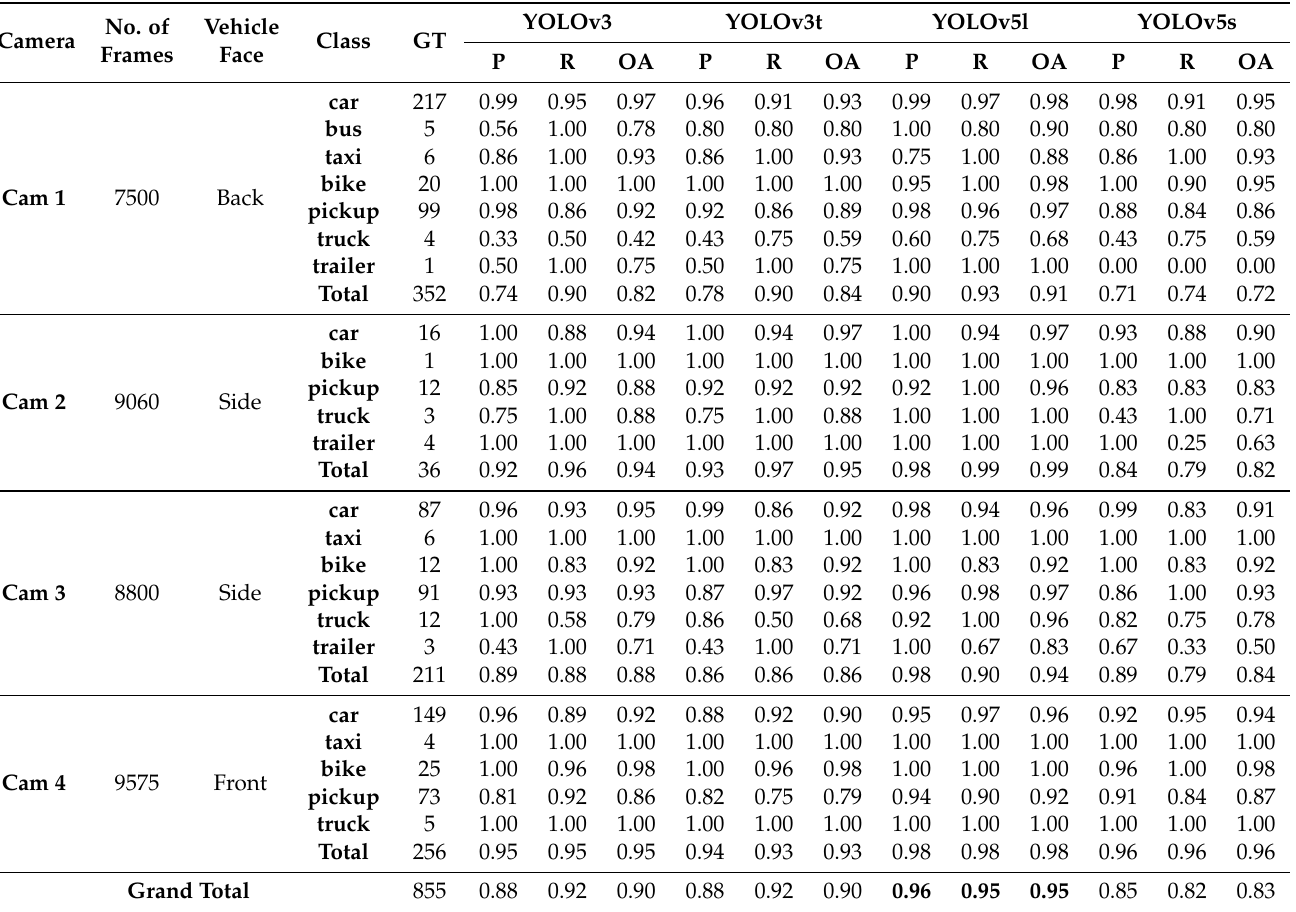
Table 5. Performance of the YOLO networks trained on TR2 evaluated on validation video streams collected from the test